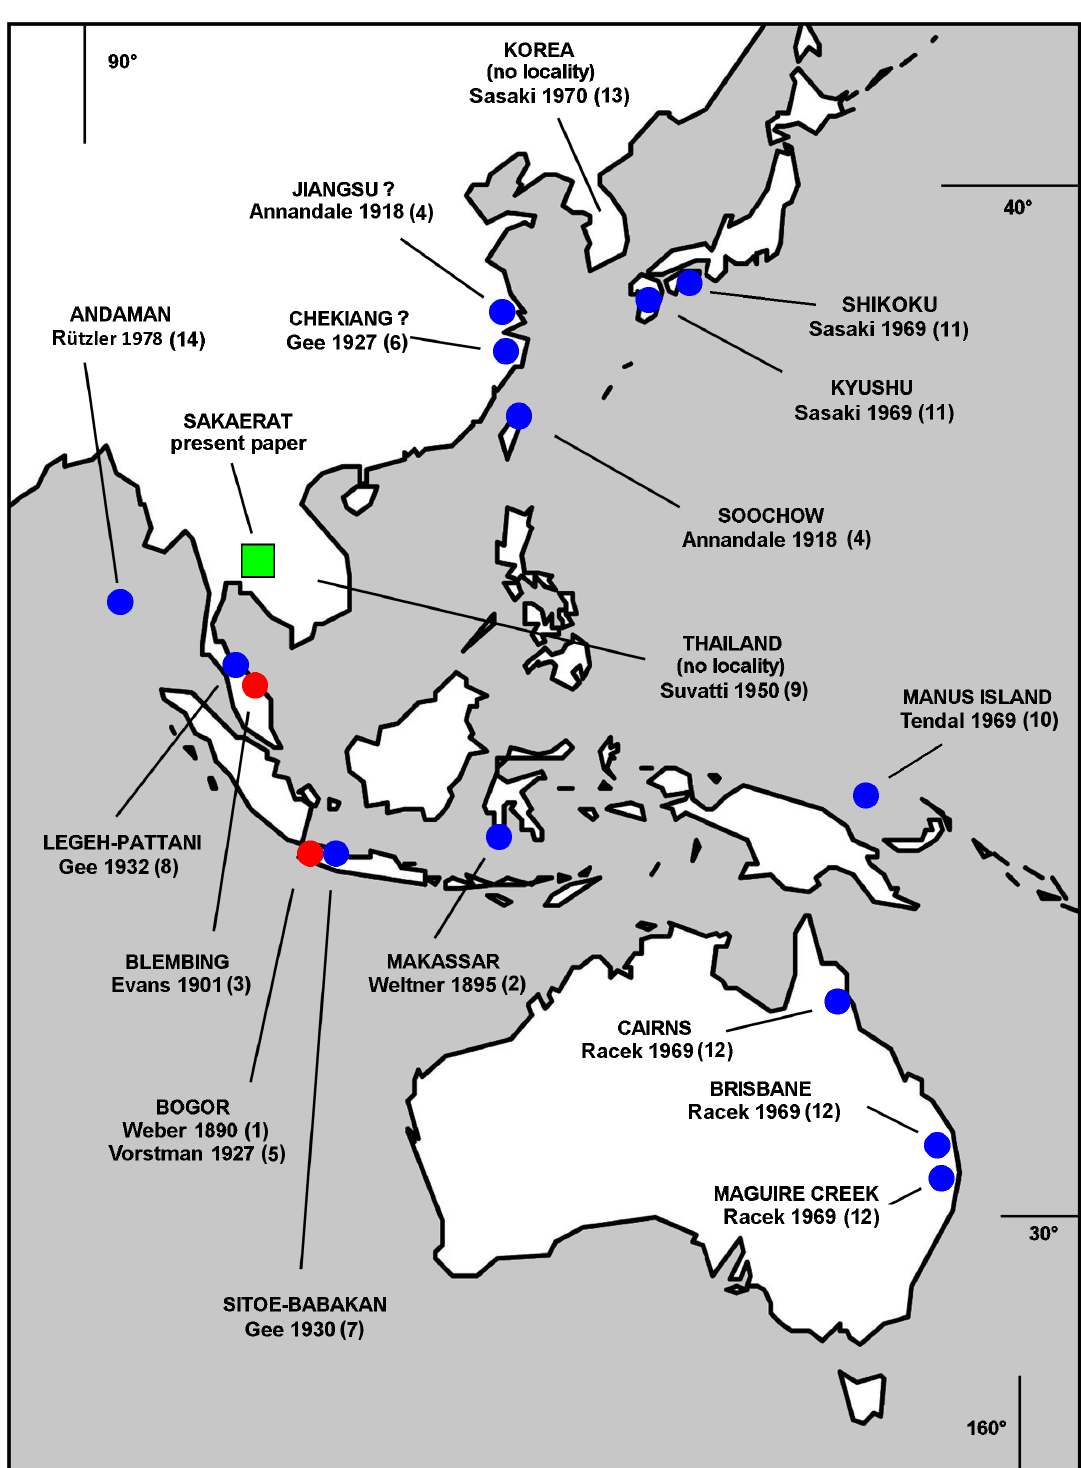
Fig. 1. Biogeographic pattern of the monotypic genus Umborotula with published records. The new record from the Sakaerat Biosphere Reserve in NE Thailand (14°30ʹ15.83″ N, 101°55ʹ03.64″ E) is indicated by the green square. For question marks, see text in the historical accounts section. The unpublished records are not reported (see Appendix). Red dots indicate the type localities of Ephydatia bogorensis Weber, 1890 and E. blembingia Evans,